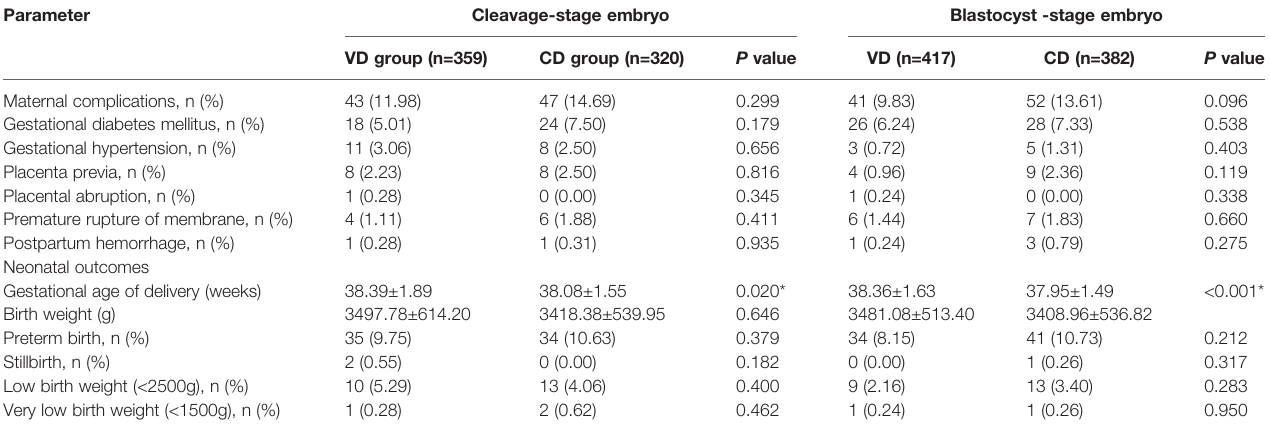
TABLE 3 | Perinatal outcomes of patients with different modes of previous